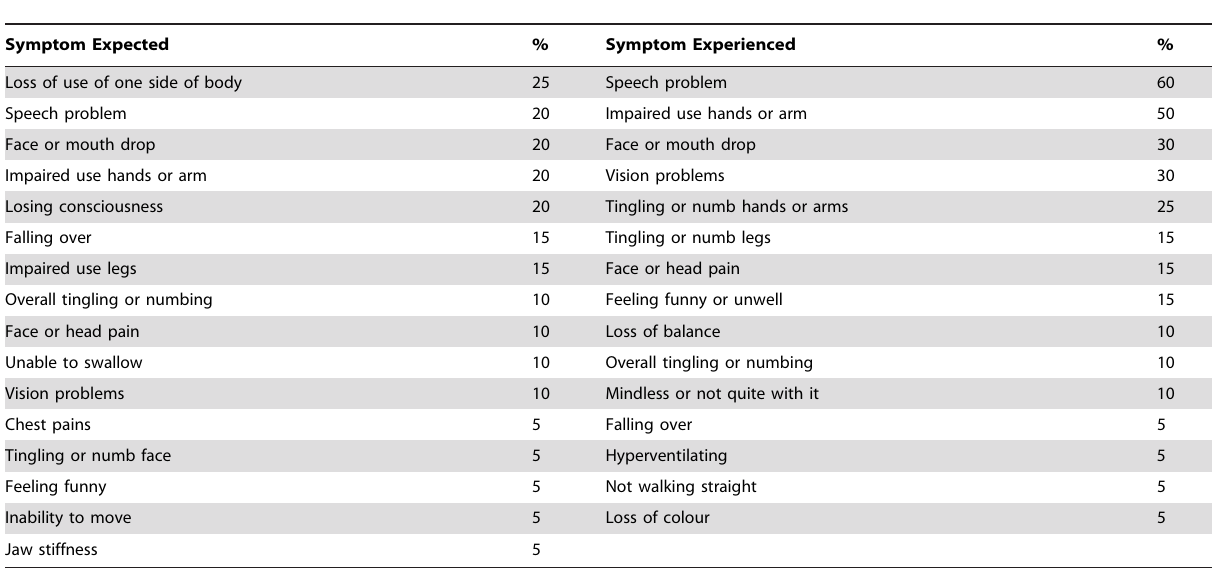
Table 2. Symptoms expected and experienced by